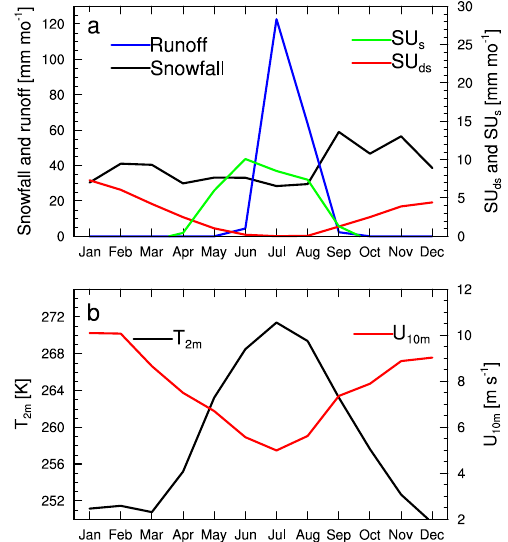
Fig. 2. Seasonal variability of (a) SMB components and (b) 2m temperatures and 10m wind speed at S10, according to RACMO2 (mean of 1960–2011, Lenaerts et al., 2012b). The left axis in (a) shows snowfall and runoff, the right axis shows drifting snow sublimation (SU ds ) and surface sublimation (SU s ). All are in mmmonth − 1 . Note the different scales of left and right